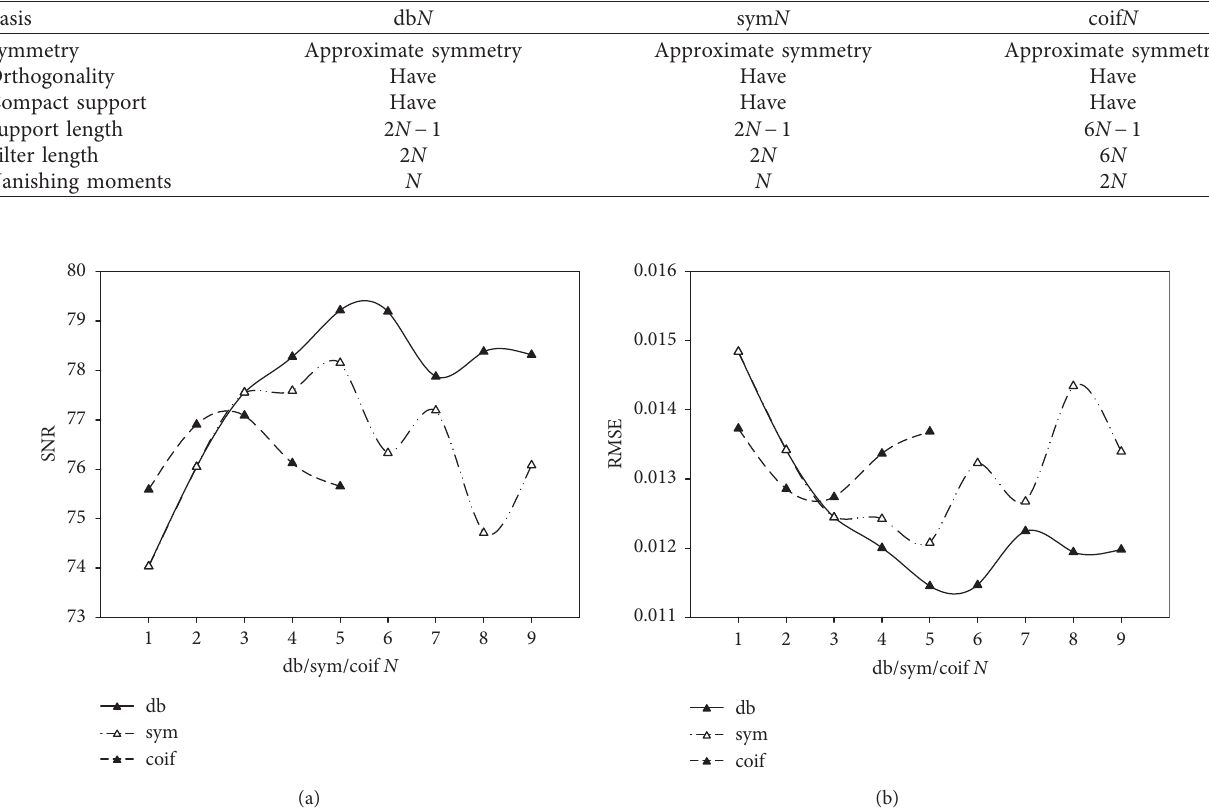
Table 1: Common wavelet bases characteristics.